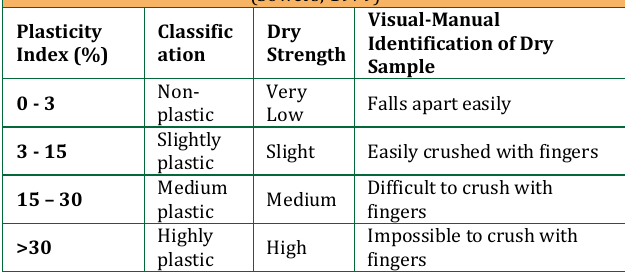
Table 3: Classification of Soil Based on Plasticity Index (Burmister, 1949)